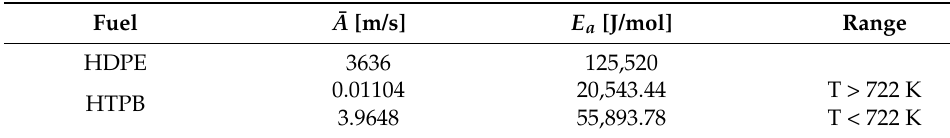
Table 4. Arrhenius constants for HDPE and HTPB [71,78,79].